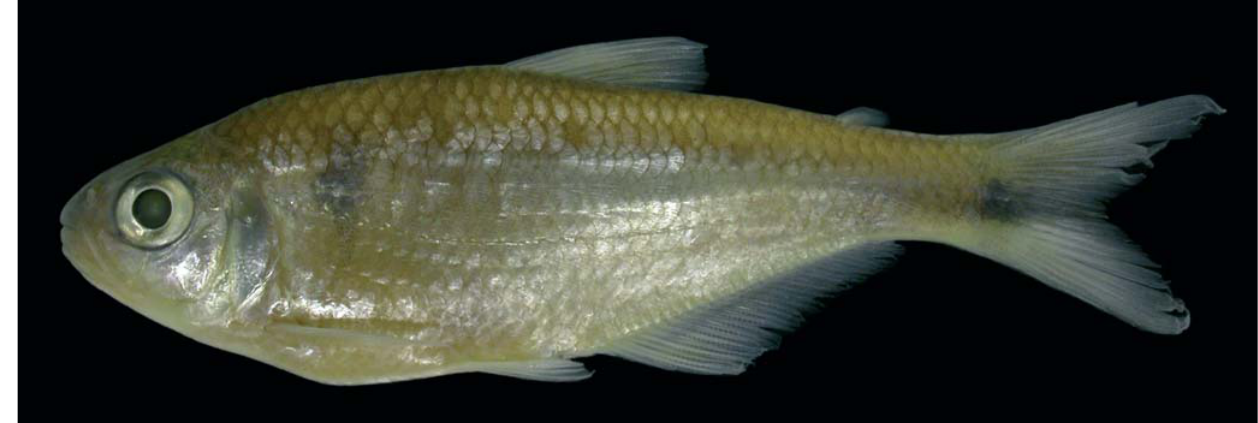
Fig. 1. Hemibrycon divisorensis , MUSM 28860, holotype, male, 68.2 mm SL; río Ucayali drainage, Loreto,